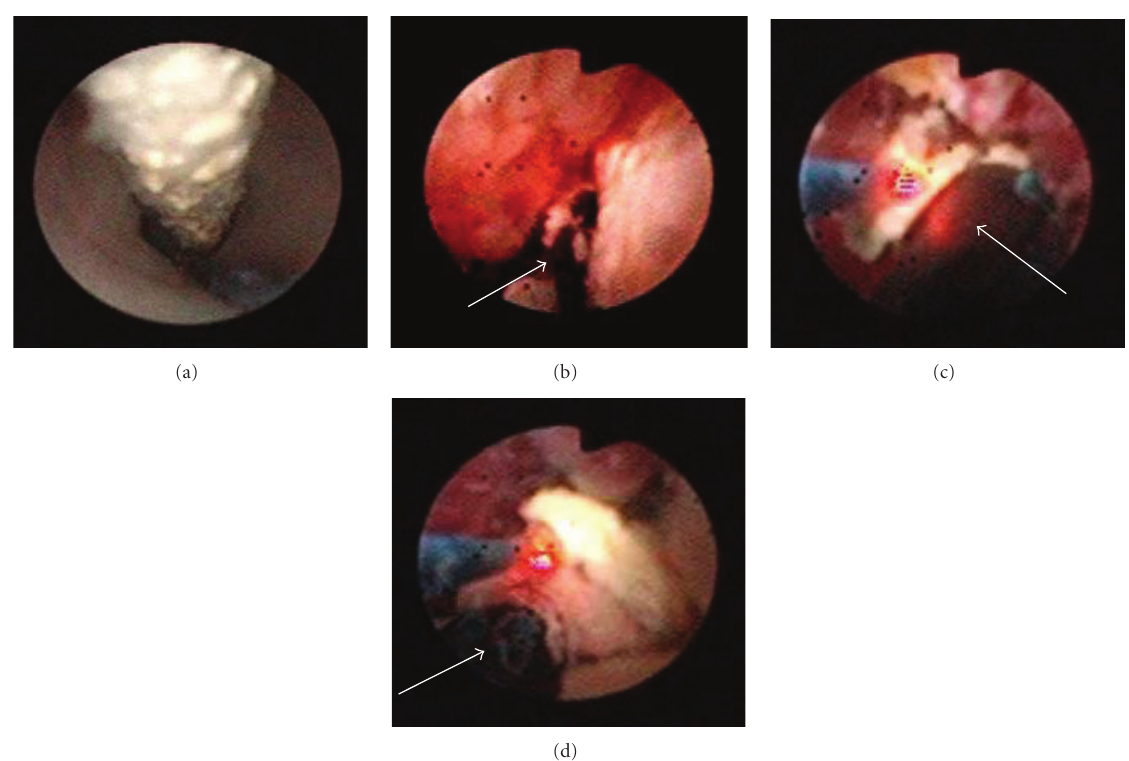
Figure 2: (a) The body of the encrusted ureteral stent. (b) Flexible URS shows that the upper end of the encrusted ureteral stent was heavily calcified to the renal stone. (c), (d) Lithotripsy around the encrusted stent using Ho: YAG laser (ureteral stent: